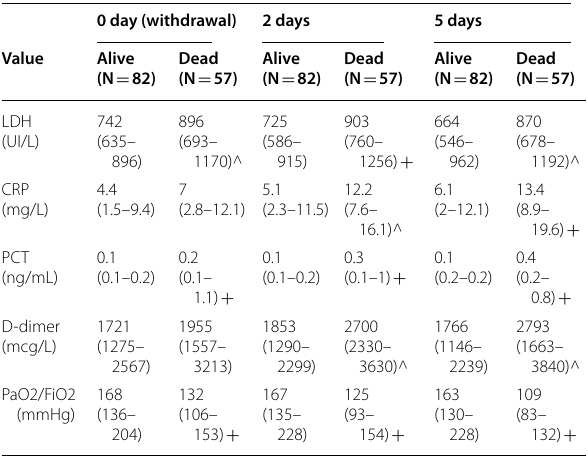
Table. Biomarkers and oxygenation index after end of steroid therapy according to